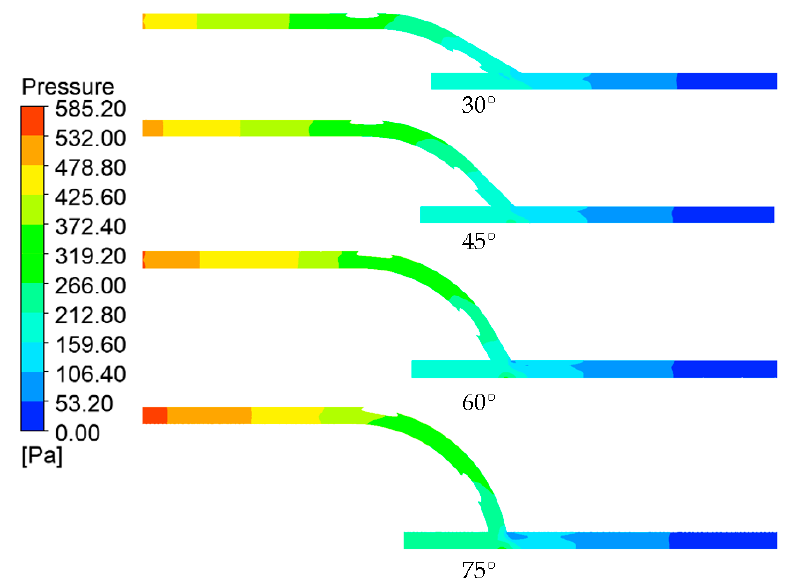
Figure 5. Pressure contours across the longitudinal section of the models.